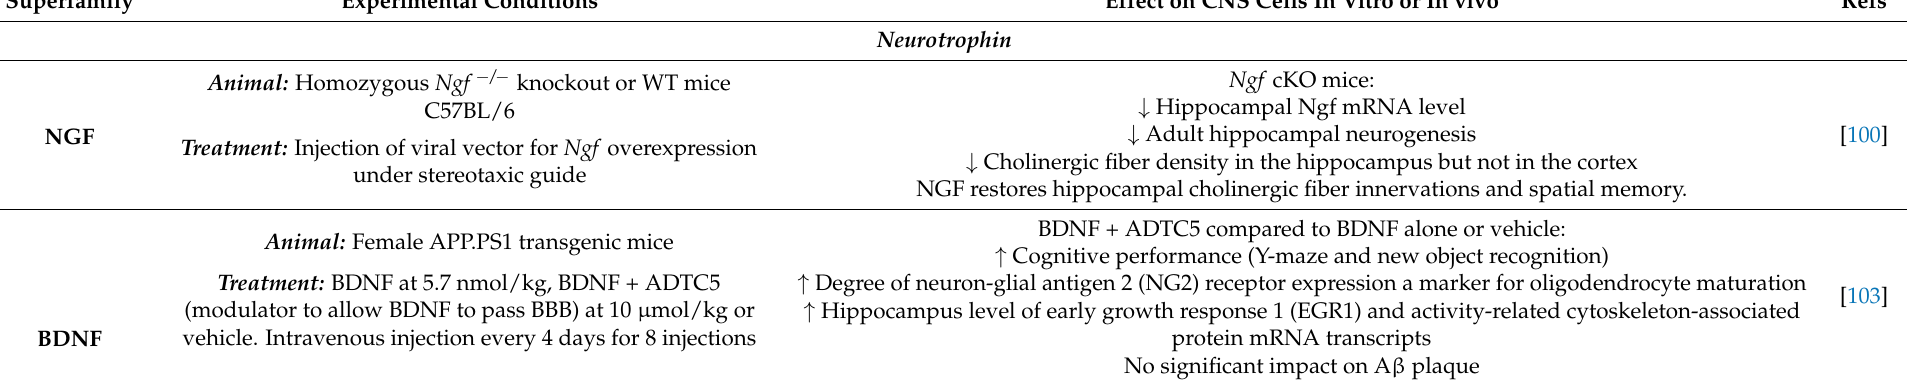
Table 1. Effect of the growth factor superfamily on CNS cells and their potential effect on Alzheimer’s disease hallmarks.